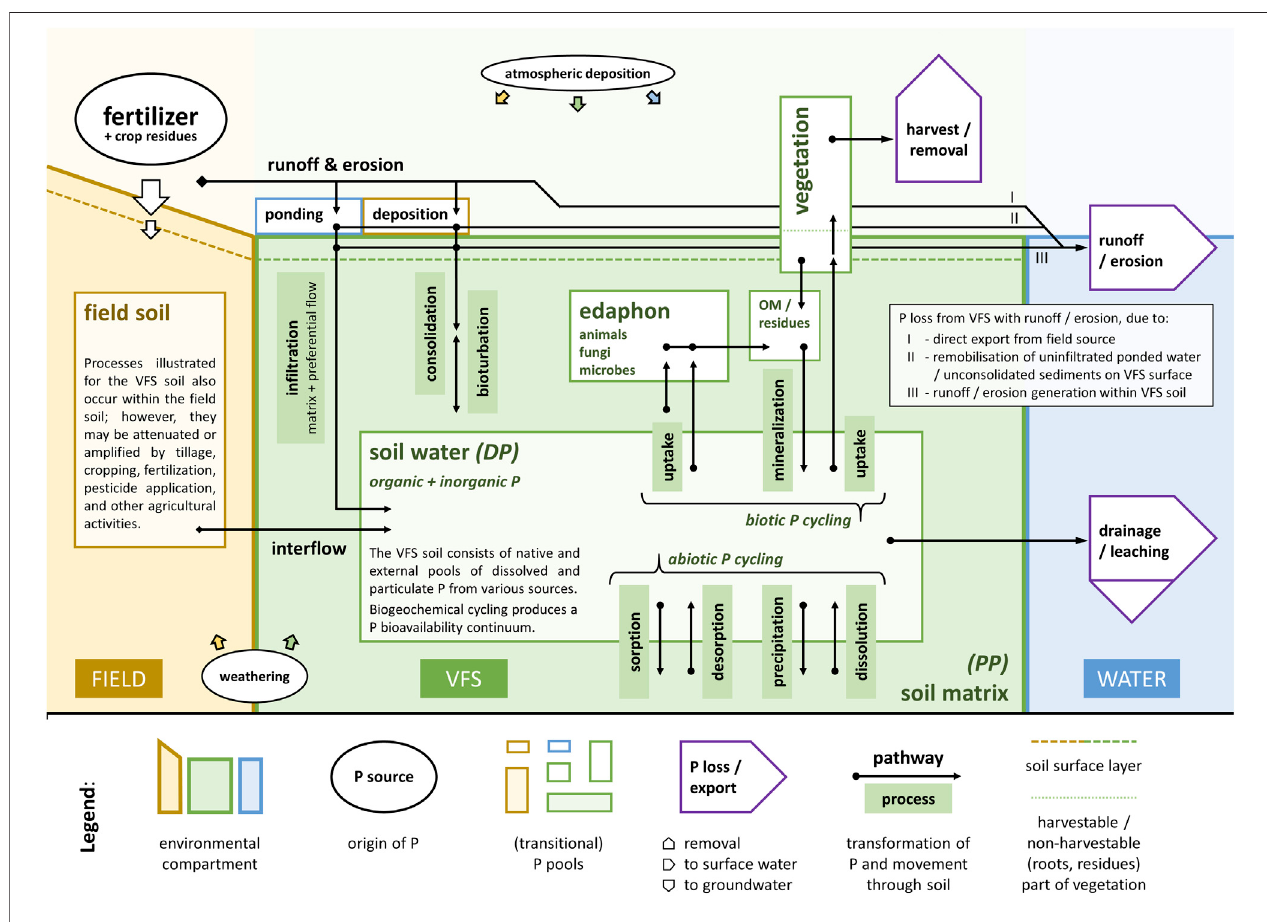
FIGURE 2 | Diagram of the most important pathways and processes of phosphorus (P) dynamics that have to be considered in VFS design and research. DP – dissolved P; PP – particulate P; OM – organic matter.